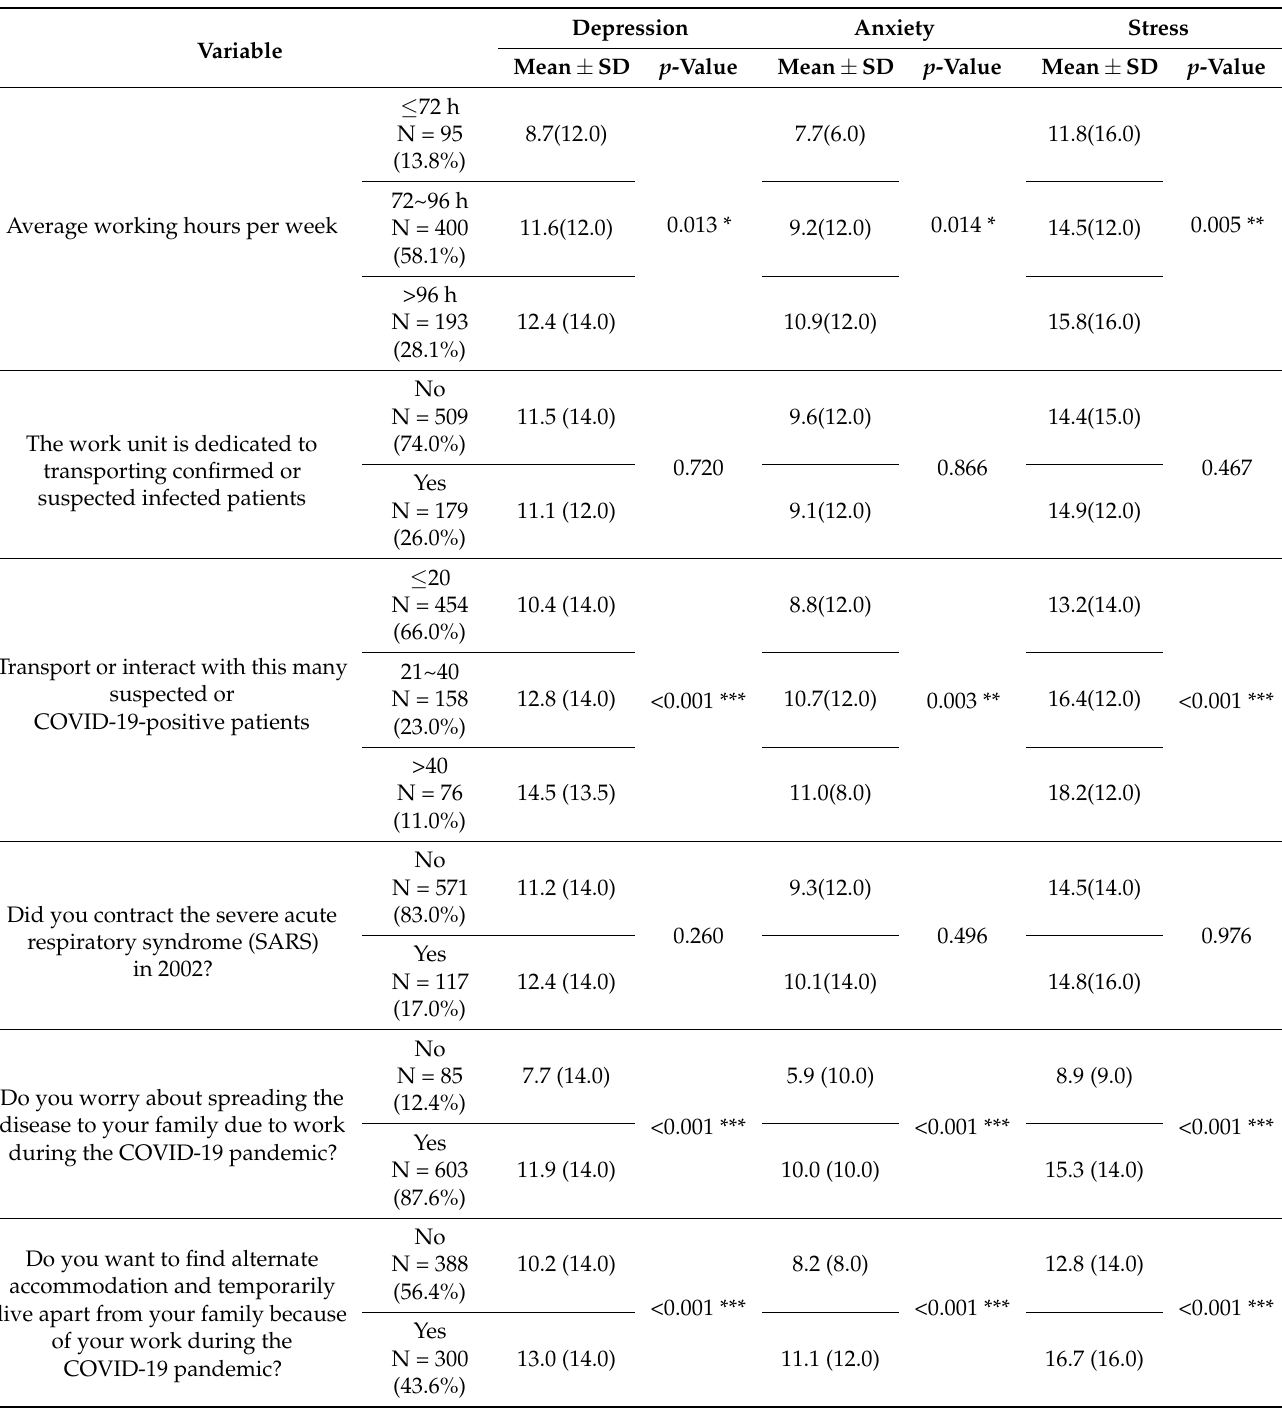
Table 2. Average scores for depression, anxiety, and stress according to different work experiences and exposure